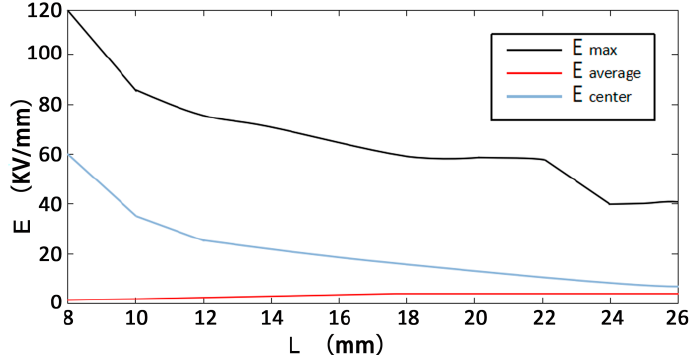
Figure 14. The electric field of rock varies with electrode spacing.